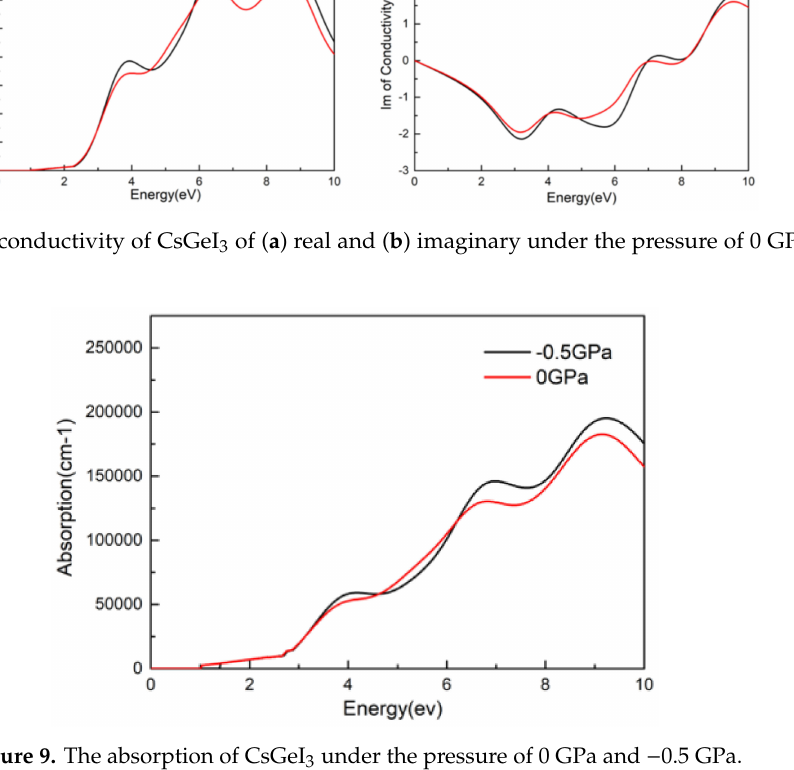
Figure 9. The absorption of CsGeI 3 under the pressure of 0 GPa and − 0.5